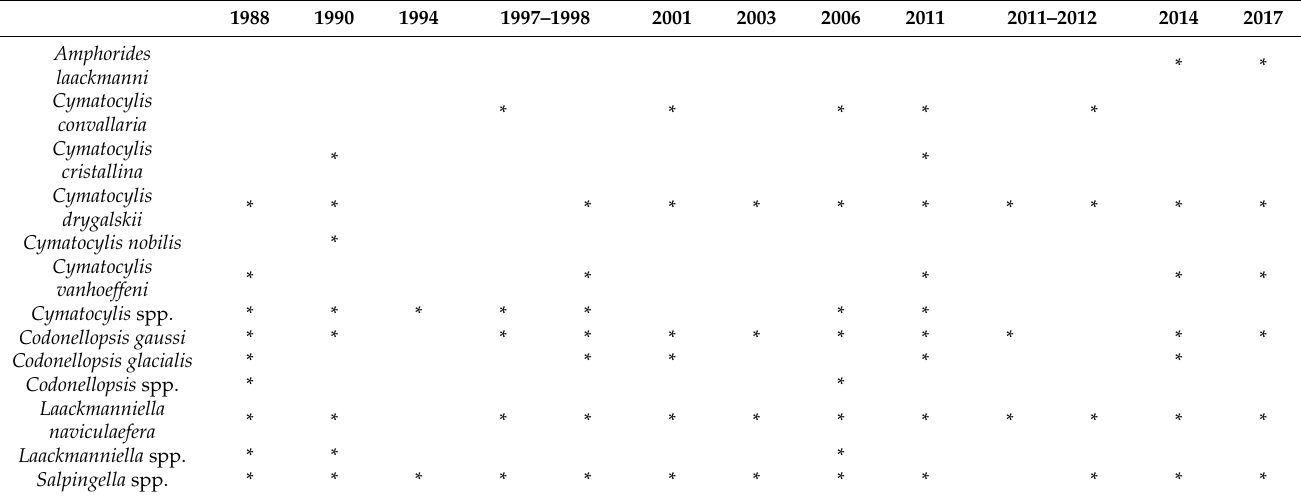
Table 2. List of tintinnid species recorded during the considered period (1988–2017) along the whole water column. (*) species